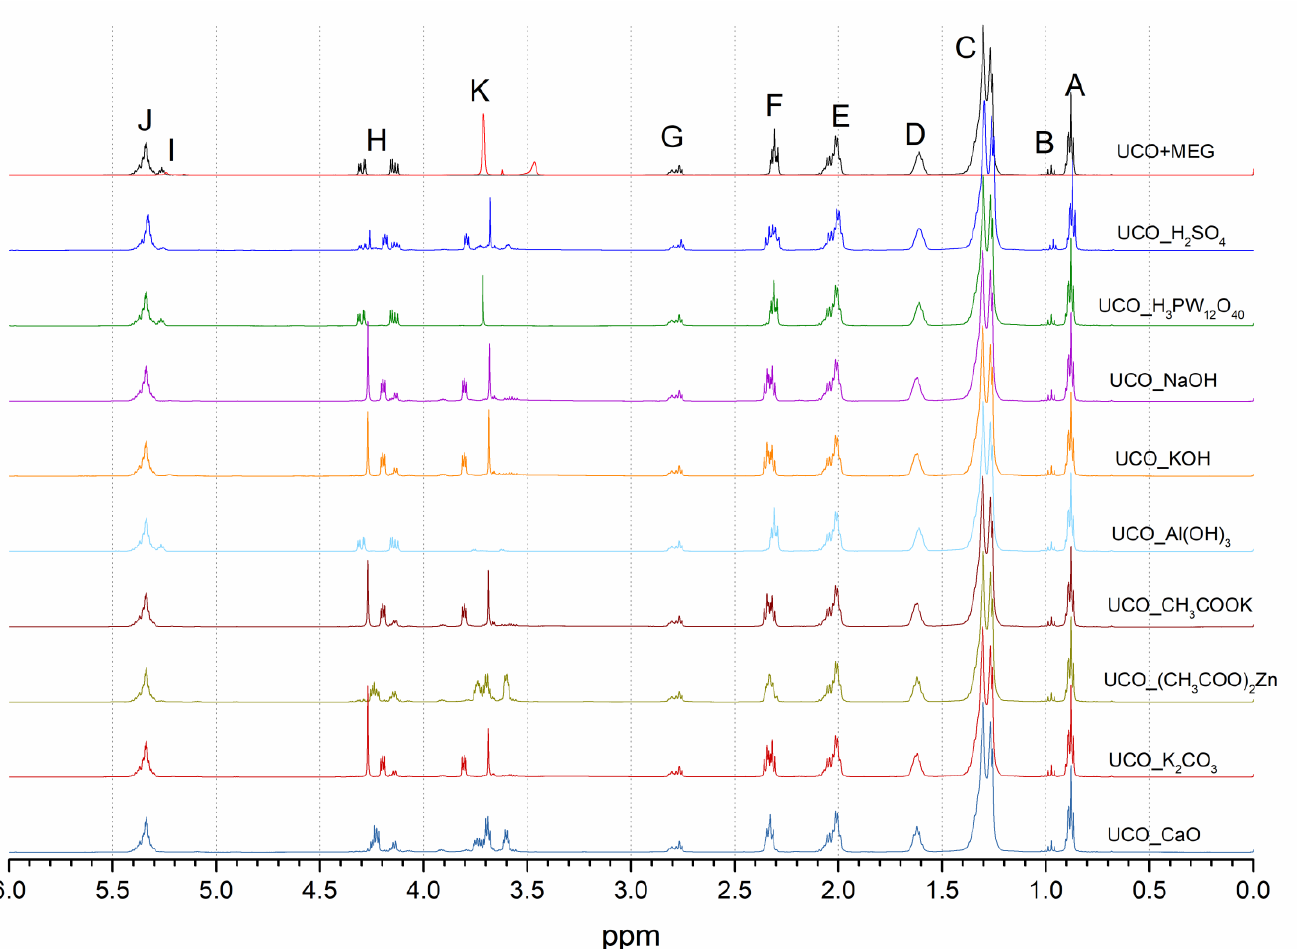
Figure 3. Overall 1 H NMR spectra of the UCO and polyols.